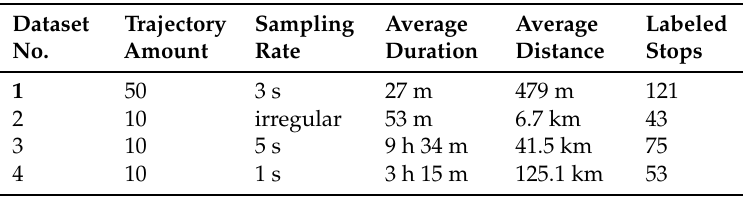
Table 2. Four experimental trajectory